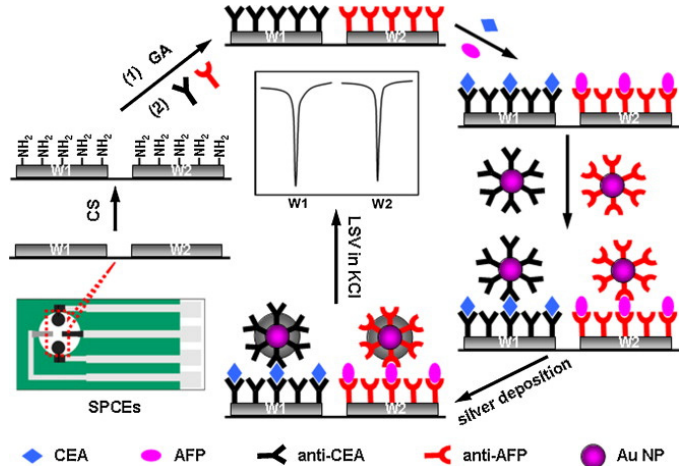
Figure 4. Schematic diagram of the assay protocol for multiplexed detection of AFP and CEA tumor biomarkers through silver NP reduction through AuNP-Ab 2 conjugates. Reprinted with permission from [68], copyright 2012 Elsevier B.V.